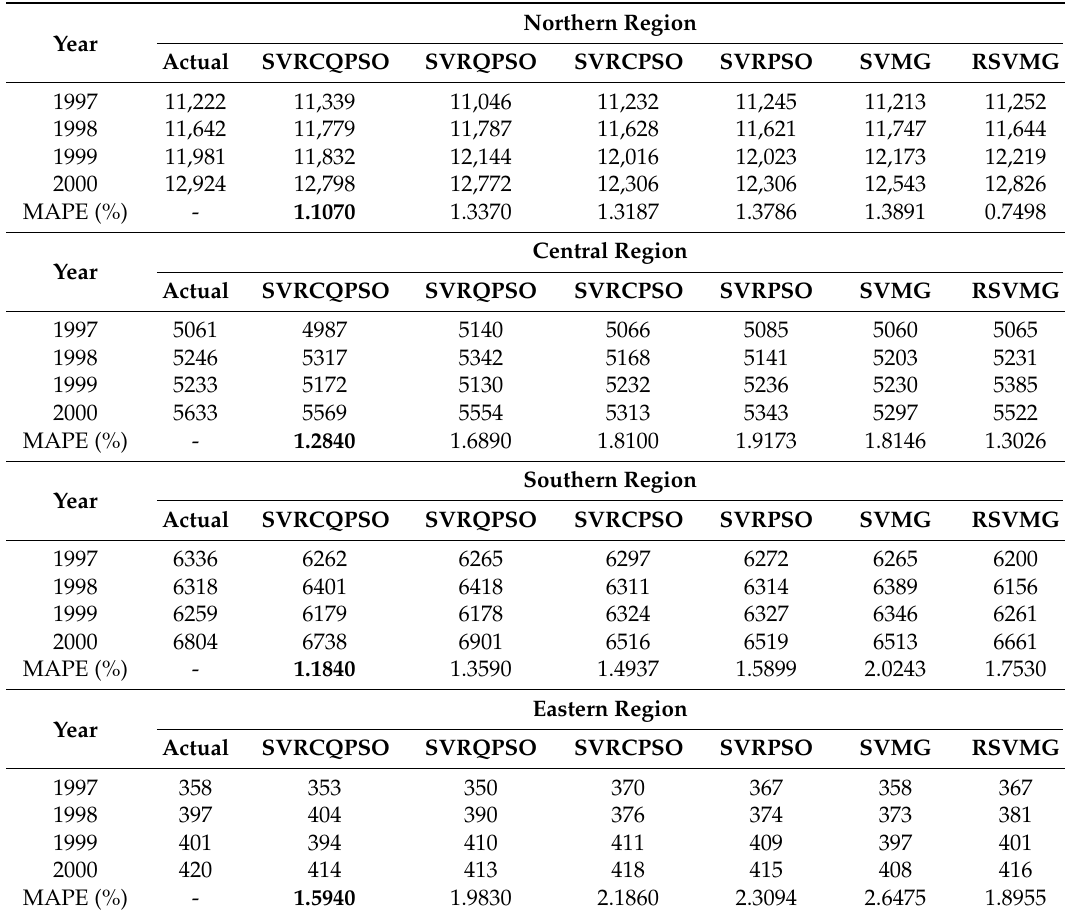
Table 2. Forecasting results of SVRCQPSO, SVRQPSO, and other models (example one) (unit: 10 6